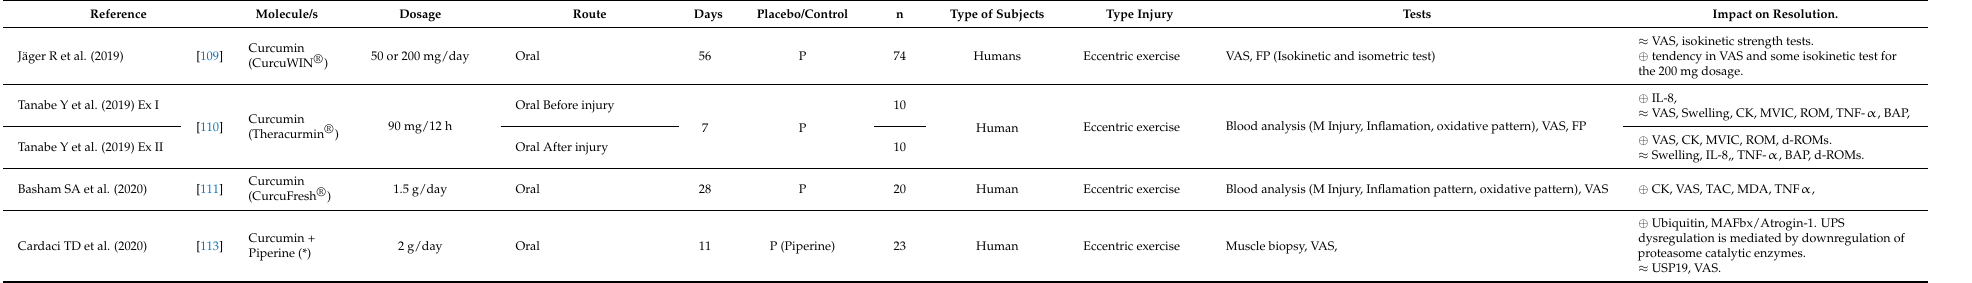
Table 2. Studies evaluating the effect of curcumin in miotendinous junction related to